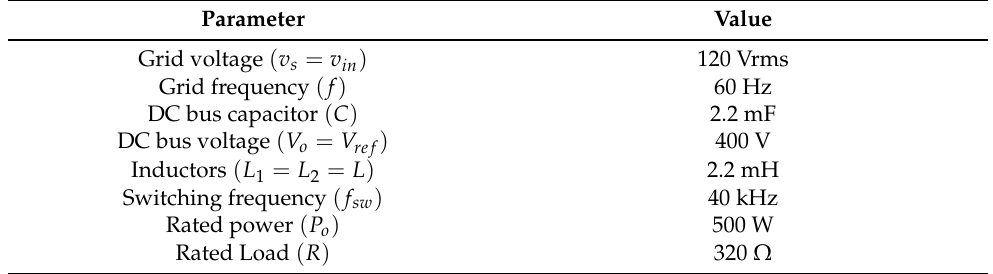
Table 2. Simulation